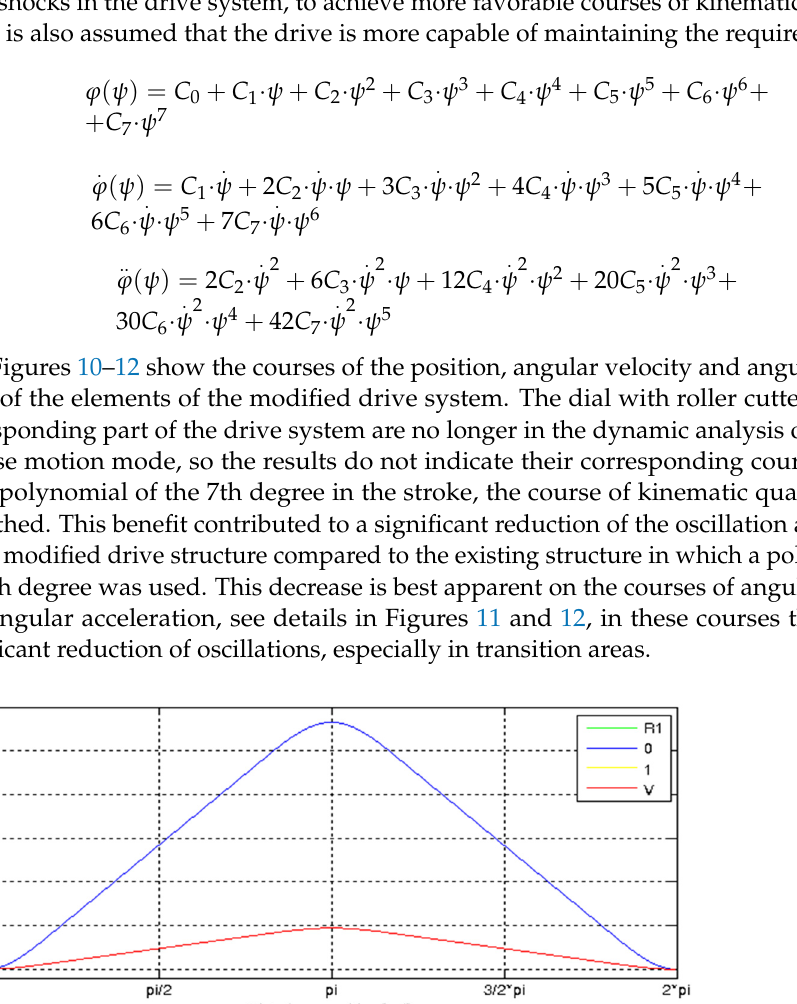
Figure 11. Courses of angular velocities of individual drive system elements.